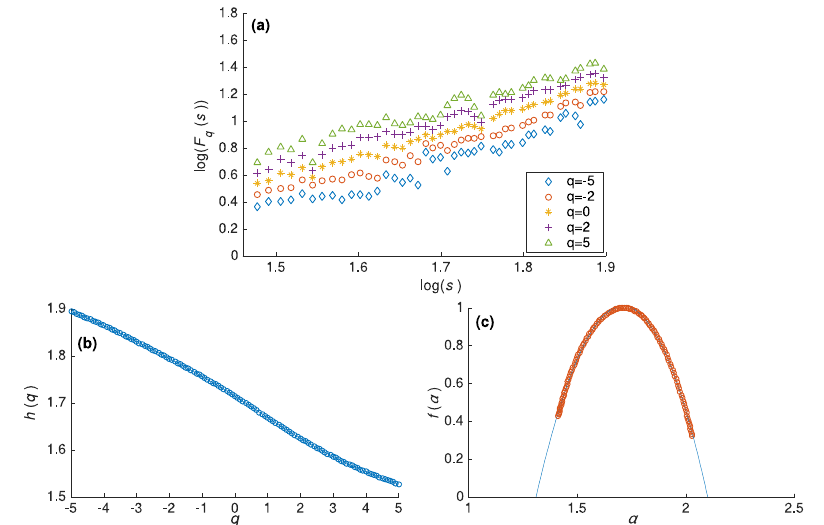
Figure 2. Multifractal Detrended Fluctuation Analysis (MF-DFA) results for global CH 4 ; ( a ) Plot of log( F q ( s )) against log( s ); ( b ) Plot of h ( q ) against q ; and, ( c ) Multifractal spectrum f ( a ) against a .